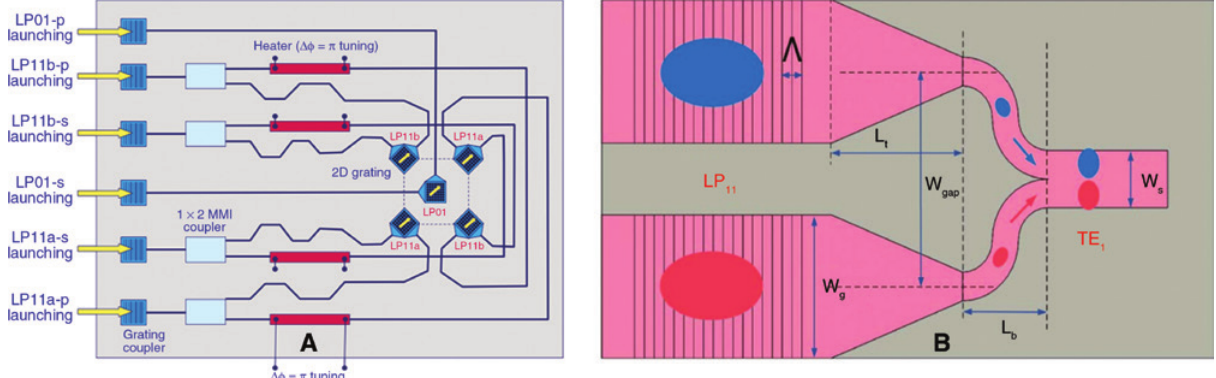
Figure 13: Grating couplers for vertical multimode coupling.